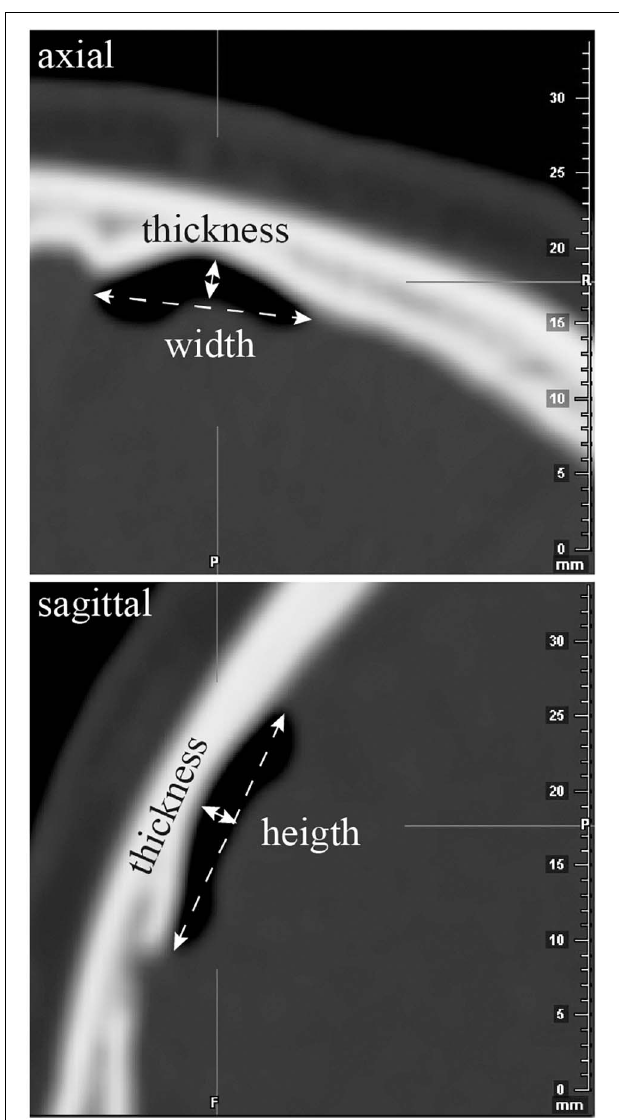
FIGURE 6 | Air bubble visible against the frontal pole on postoperative CT scan. Principle of the measurements of the width, thickness, and height of the bubble air on axial and sagittal CT-scan